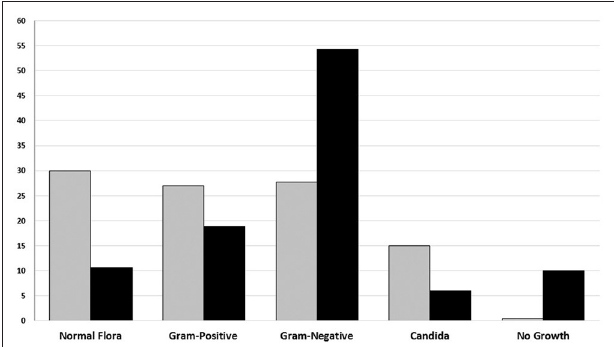
FIGURE 1 | The percentage of Groups of microorganism based on sputum culture result from January to June 2018 in Tertiary Sanglah Referral Hospital in Bali, Indonesia. Gray and filled boxes are poor and good-quality sputum, respectively.